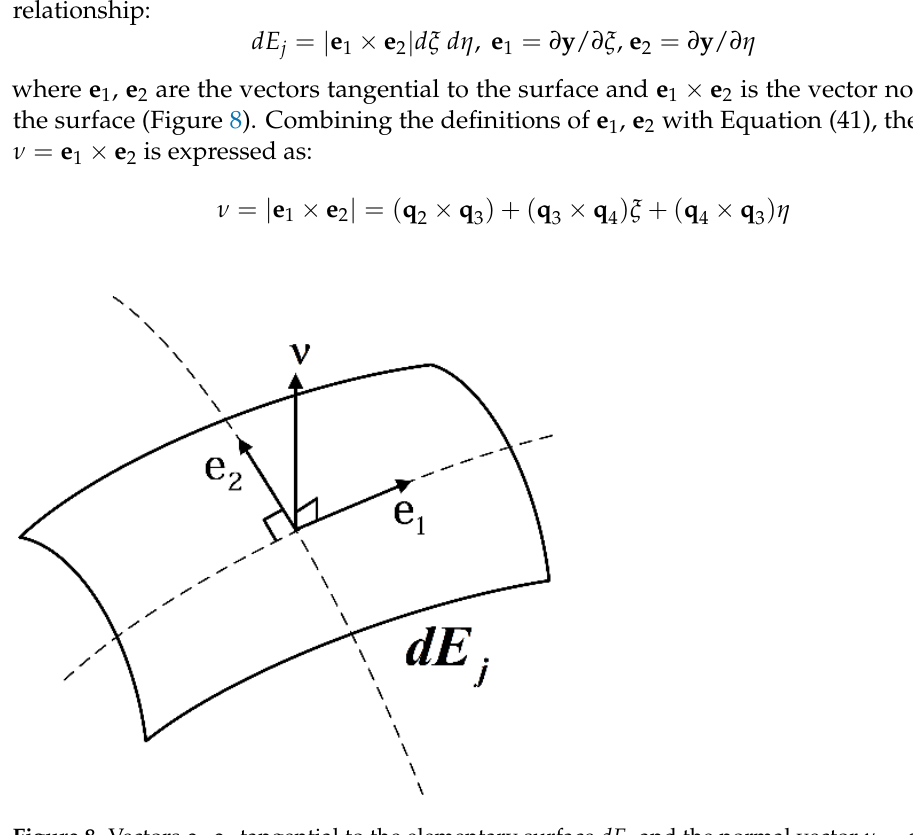
= ×ν e e and the normal vector j 1 2